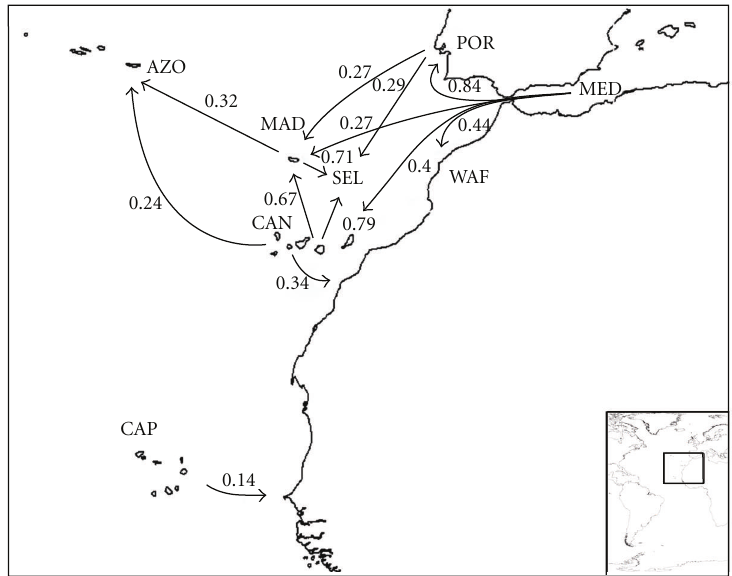
Figure 6: Probable colonization patterns of rissoid fauna in the Macaronesian islands, Northeast - Atlantic, and Mediterranean. The arrows represent the probable main flux direction of faunas, and the associated numbers represent, for each pair of areas, the higher of the two similarity index values computed as described in the methods, abbreviations as in Table